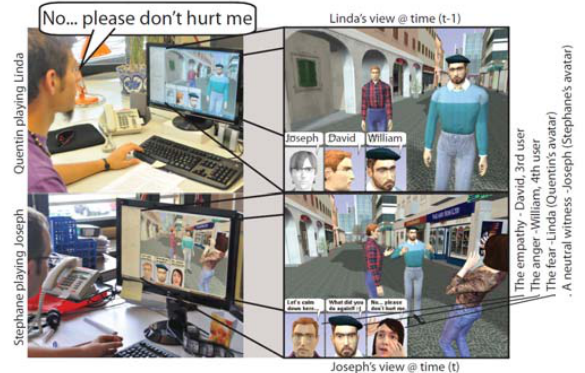
Figure 8. Example of a 3D-chatting scenario involving animated non-verbal communication expressing three emotions, i.e. empathy, anger, and fear. Please note that the text in the top left bubble is typed by the